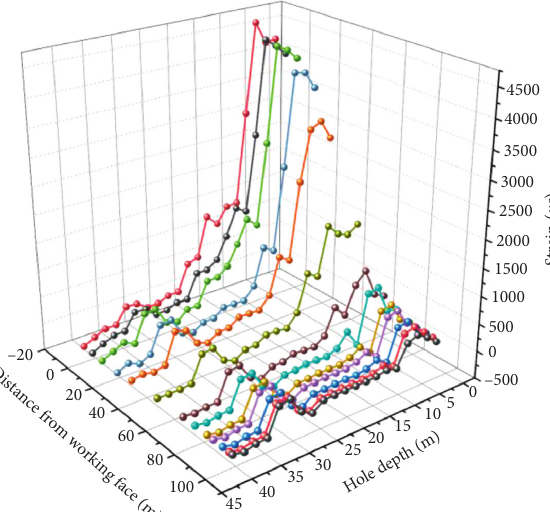
Figure 8: Fixed-point fiber grating detection results.